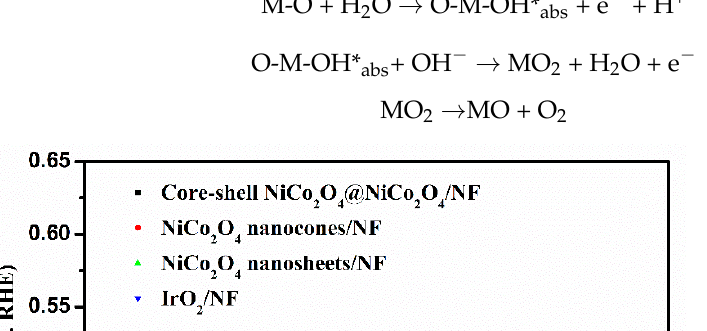
Figure 8. The electrochemical impedance spectra of core-shell NiCo 2 O 4 @NiCo 2 O 4 /NF composites, NiCo 2 O 4 nanosheets, NiCo 2 O 4 nanocones.